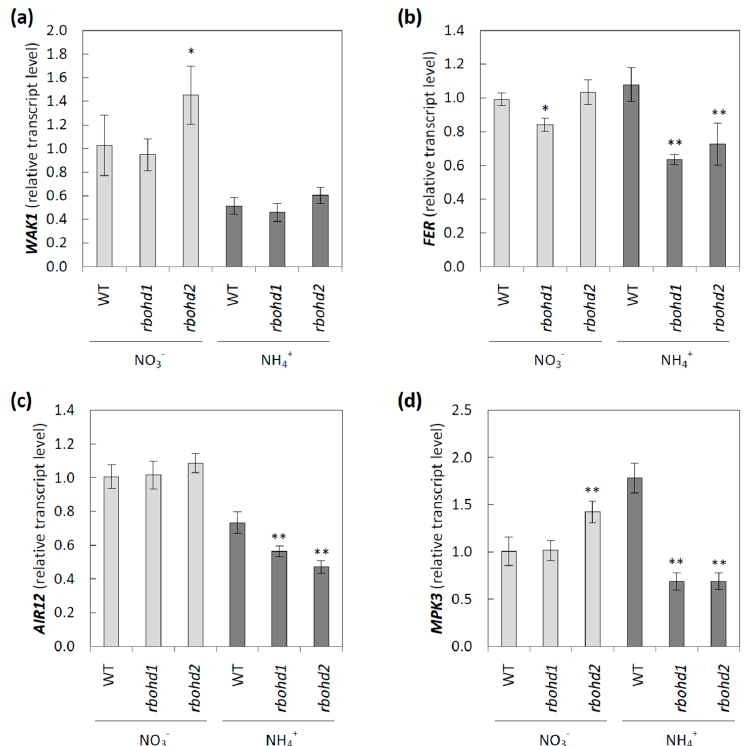
Figure 6. Signaling pathways related to cell-wall changes or to apoplastic reactive oxygen species metabolism in WT and rbohd plants grown in nitrate or ammonium as a sole nitrogen source. The transcript level of cell wall-associated kinase 1 ( a ), feronia ( b ), auxin-induced in root cultures 12 ( c ), and mitogen-activated protein kinase 3 ( d ). Comparison tests between rbohd and WT plants were performed on the mean experimental conditions for the nitrate (light grey) or ammonium (dark grey) growth regime separately. Statistical differences calculated using one-way analysis of variance (ANOVA) with Tukey’s post hoc test are indicated at p -value ≤ 0.01 ** and p -value ≤ 0.05